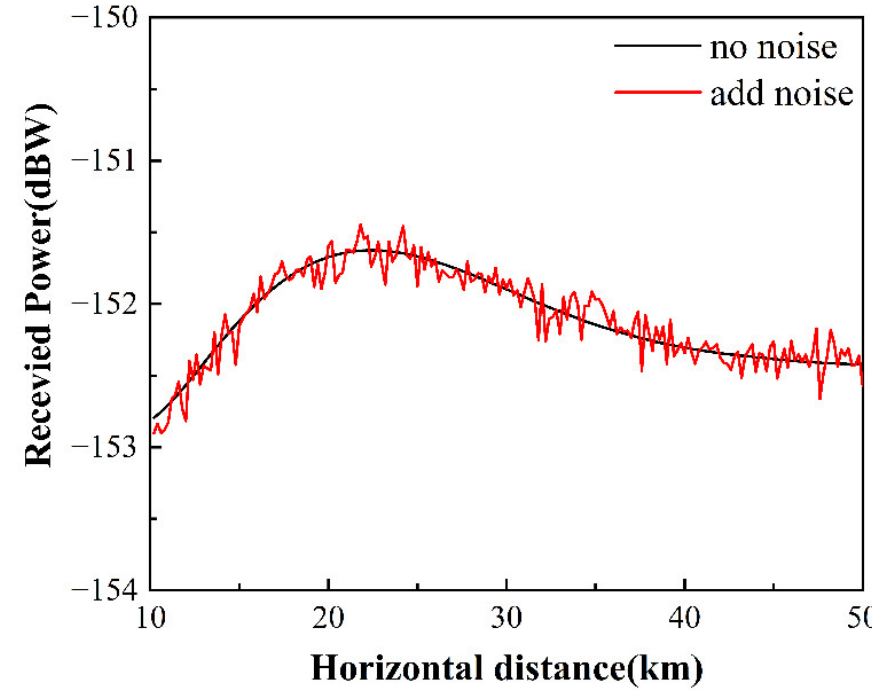
Figure 7. The curve of GPS receiving power with distance.